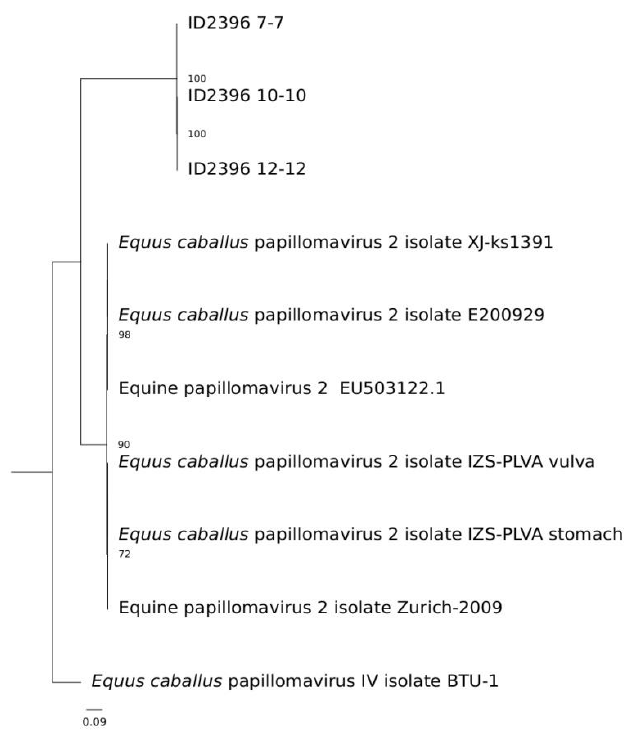
Figure 3. Phylogenetic analysis of the L1 gene sequence from the three reconstructed samples (ID2396 7-7-, 10-10, and 12-12) and other EcPV2 isolates available in the NCBI database. EcPV4 was used as the outgroup, and the bootstrap value indicating clustering robustness is indicated.